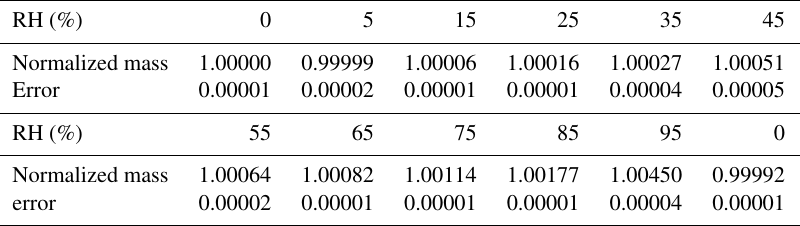
Table A1. Normalized mass of CaSO 4 · 2H 2 O as a function of RH at 25 ◦